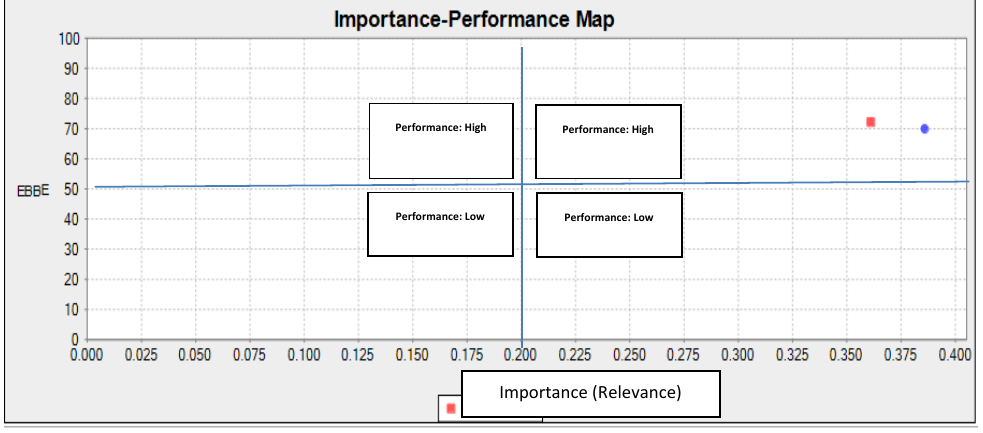
Fig. 2. Importance – Performance Matrix for